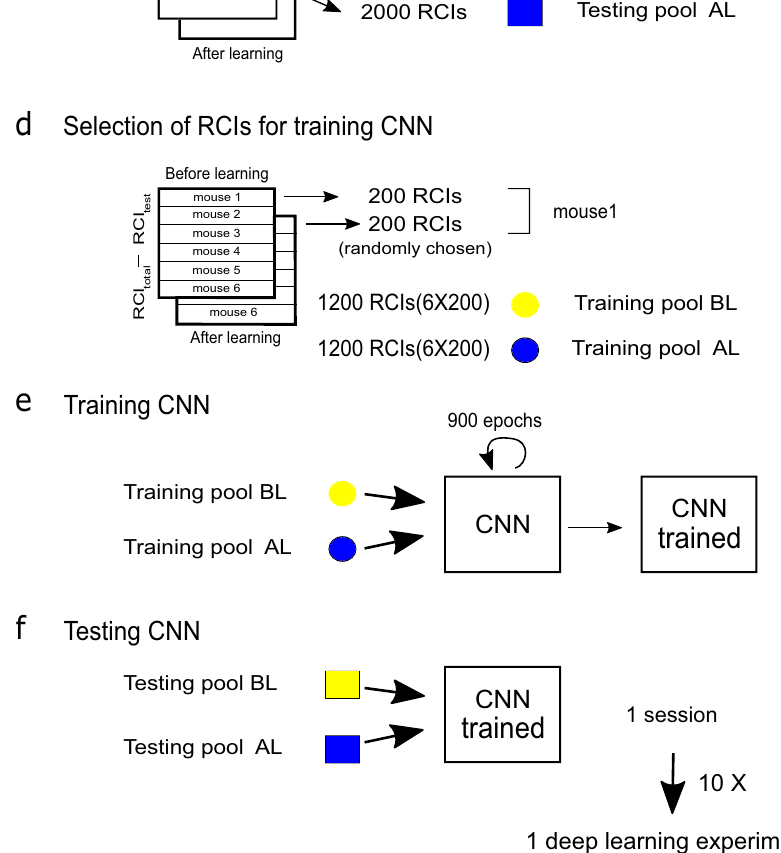
Figure 1. Schematic representation of behavioral and deep learning experiments. ( a1 ) Electrophysiological recording was performed in the home cage during 90 min before and after visiting the maze, where the animal had to find the position of 3 baited arms. ( a2 ) Acquisition of the reference memory was similar in WT and APP/PS1 groups. ( b–f ) 256 ms intervals of LFP signals recorded in CA1 during slow-wave sleep and centered at a single SWR ( b ) were randomly chosen to constitute the testing ( c ) and training data pools ( d ). Each of the 10 sessions of the deep learning experiment consisted of the training of CNN during 900 epochs on a new training pool ( e ) and the test on the same fixed test pool ( f